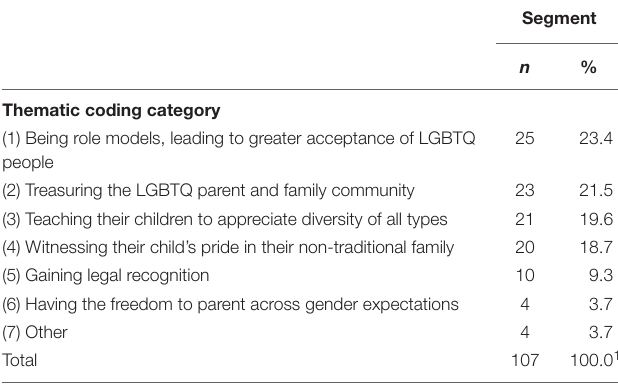
TABLE 3 | Best parenting